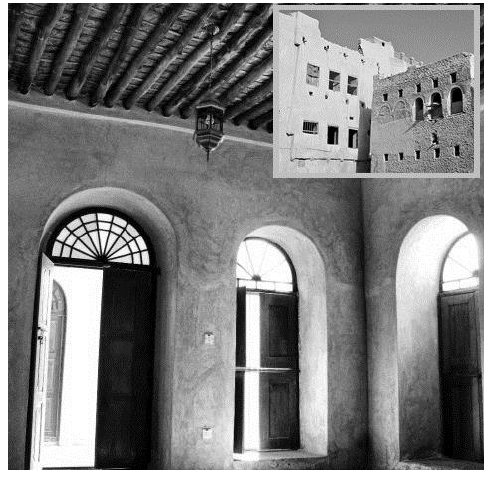
Figure 1. The vernacular house of the Arabian Gulf type.